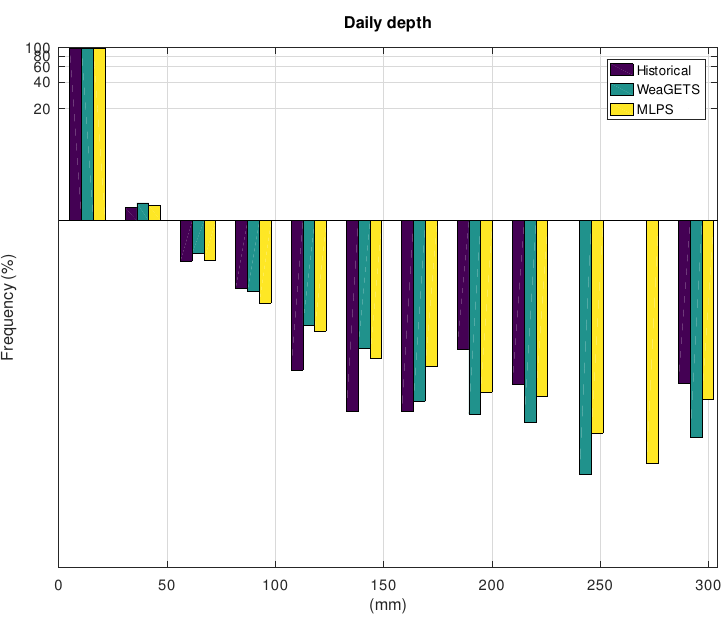
Figure 11. Histogram of the daily synthetic time series (WeaGETS and MLPS) and historical values of the Gibraltar weather station.